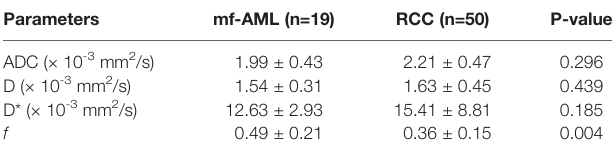
TABLE 2 | Comparison of the IVIM-DWI parameters between mf-AML and RCC